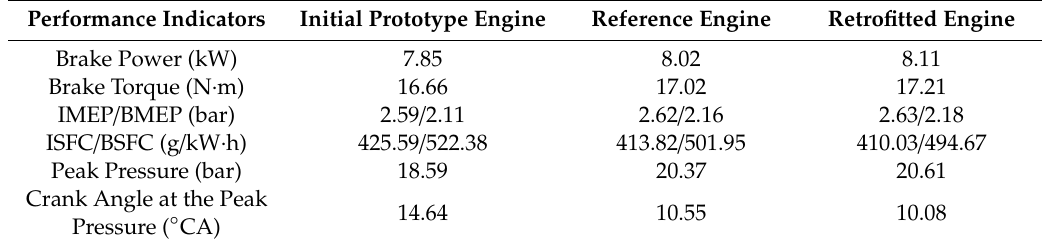
Table 21. Comparative simulation results of the minimum load operation condition (heavy fuel).